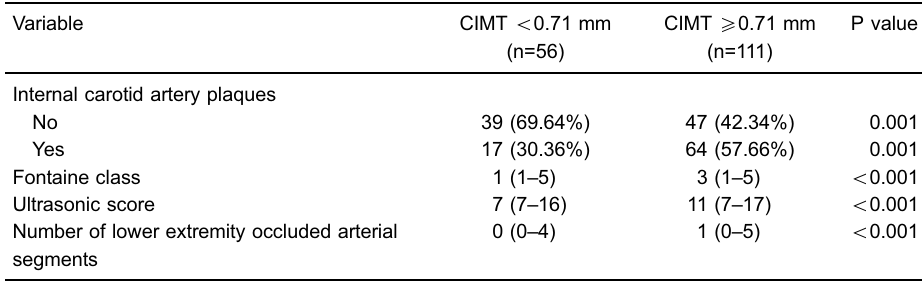
Table 4. Comparison of internal carotid artery plaque prevalence, Fontaine class, ultrasonic score, and number of lower extremity occluded segments between subgroups based on carotid intima-media thickness (CIMT).